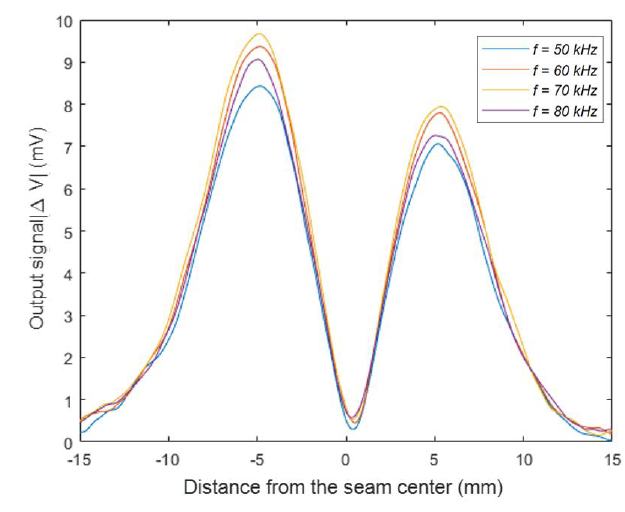
Figure 14. The sensor output signal at different excitation frequencies with a 2 mm-thick cover panel.